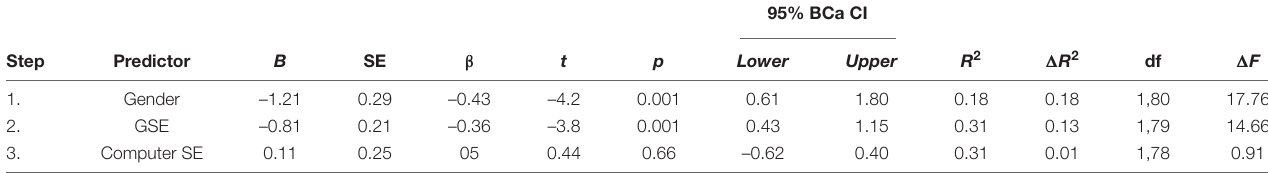
TABLE 4 | Summary of hierarchical regression for the prediction of